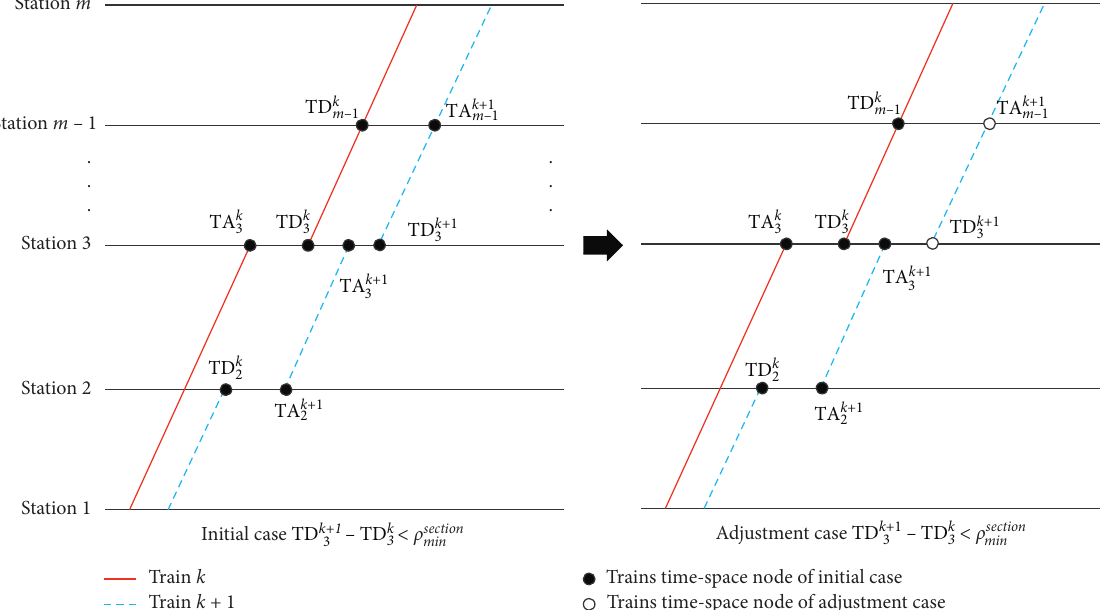
Figure 11: Adjustment method of section